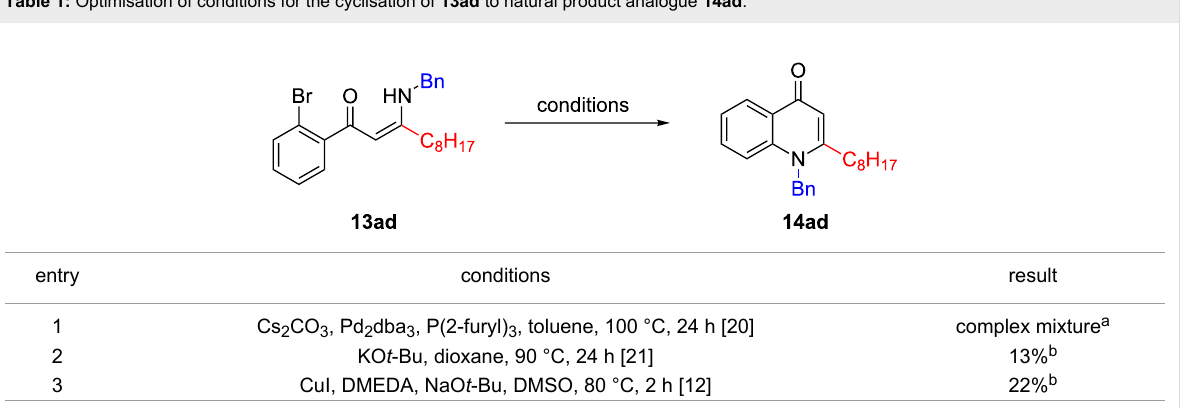
Table 1: Optimisation of conditions for the cyclisation of 13ad to natural product analogue 14ad